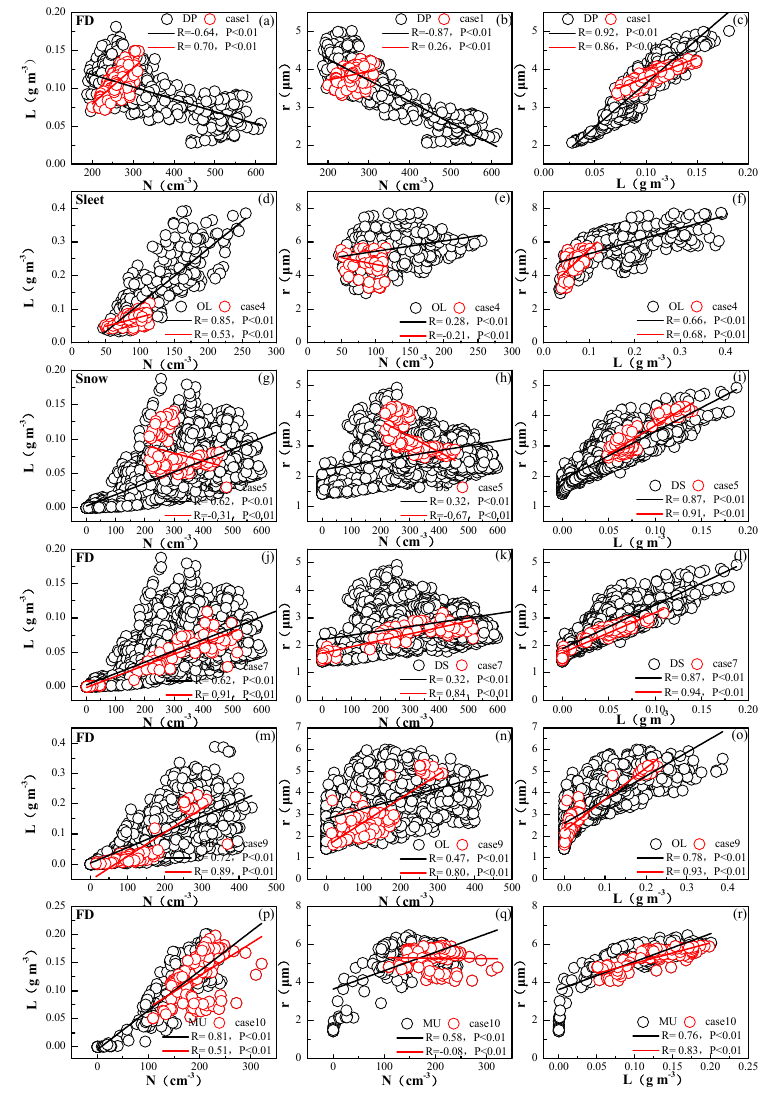
Figure 6. Relationships among N , r , and L under the effects of freezing drizzle, sleet, and snow during the development, maturity, dissipation, and oscillation periods of fog. ( a ) Liquid water content ( L ) as a function of number concentration ( N ); ( b ) radius ( r ) as a function of N ; ( c ) r as a function of L during the freezing drizzle event in development period of fog; ( d ) L as a function of N ; ( e ) r as a function of N ; ( f ) r as a function of L during the sleet event in oscillation period of fog; ( g ) L as a function of N ; ( h ) r as a function of N ; ( i ) r as a function of L during the snow event in dissipation period of fog; ( j ) L as a function of N ; ( k ) r as a function of N ; ( l ) r as a function of L during the freezing drizzle event in dissipation period of fog; ( m ) L as a function of N ; ( n ) r as a function of N ; ( o ) r as a function of L during the freezing drizzle event in oscillation period of fog; ( p ) L as a function of N ; ( q ) r as a function of N ; ( r ) r as a function of L during the freezing drizzle event in maturity period of fog.